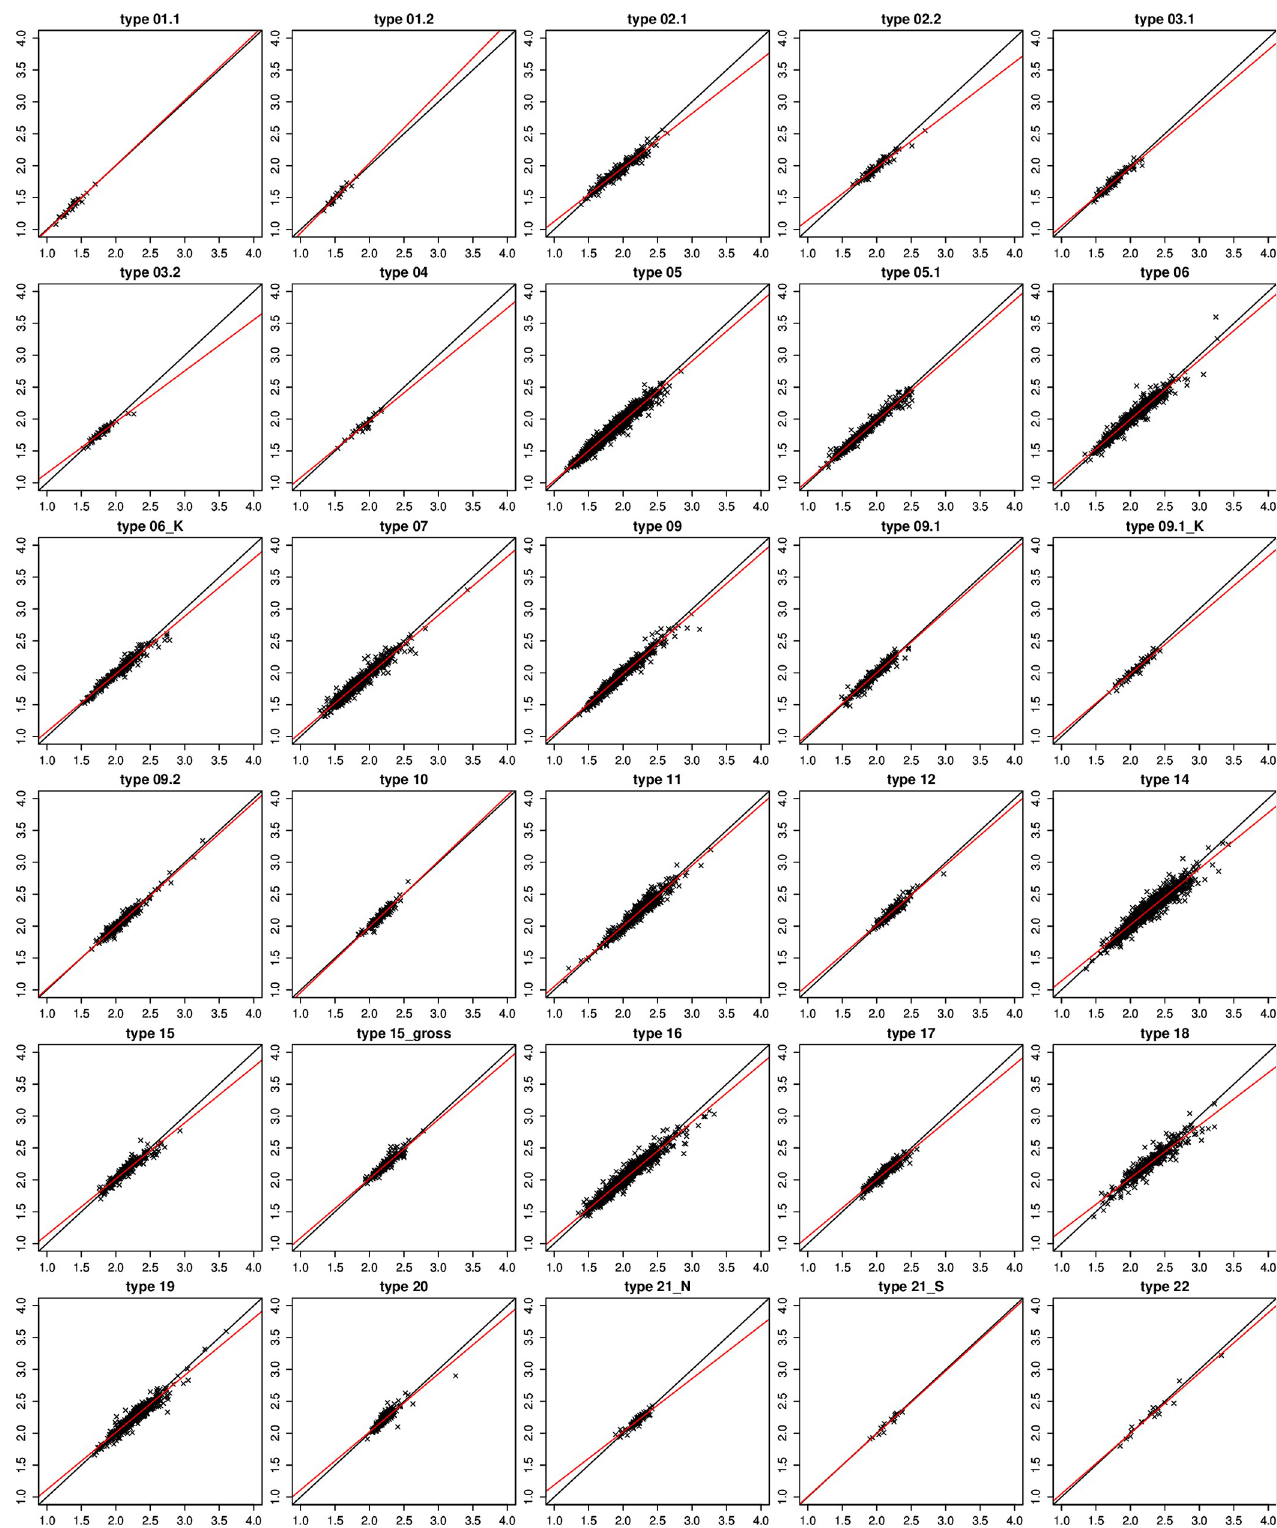
Fig 6. Regression analysis of presence/absence ( y -axis) and abundance-based data ( x -axis) for the German saprobic index (organic pollution module, OPM).